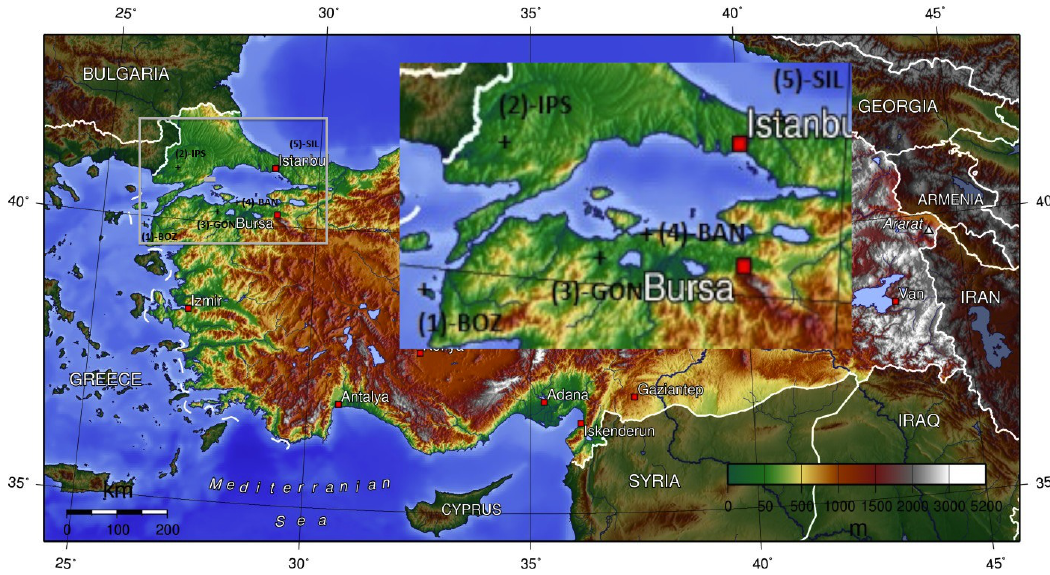
Figure 3. The topographic map of Turkey—A portion is zoomed for visual purposes. ("Turkey topo" by Captain Blood—Licensed under CC BY-SA 3.0)